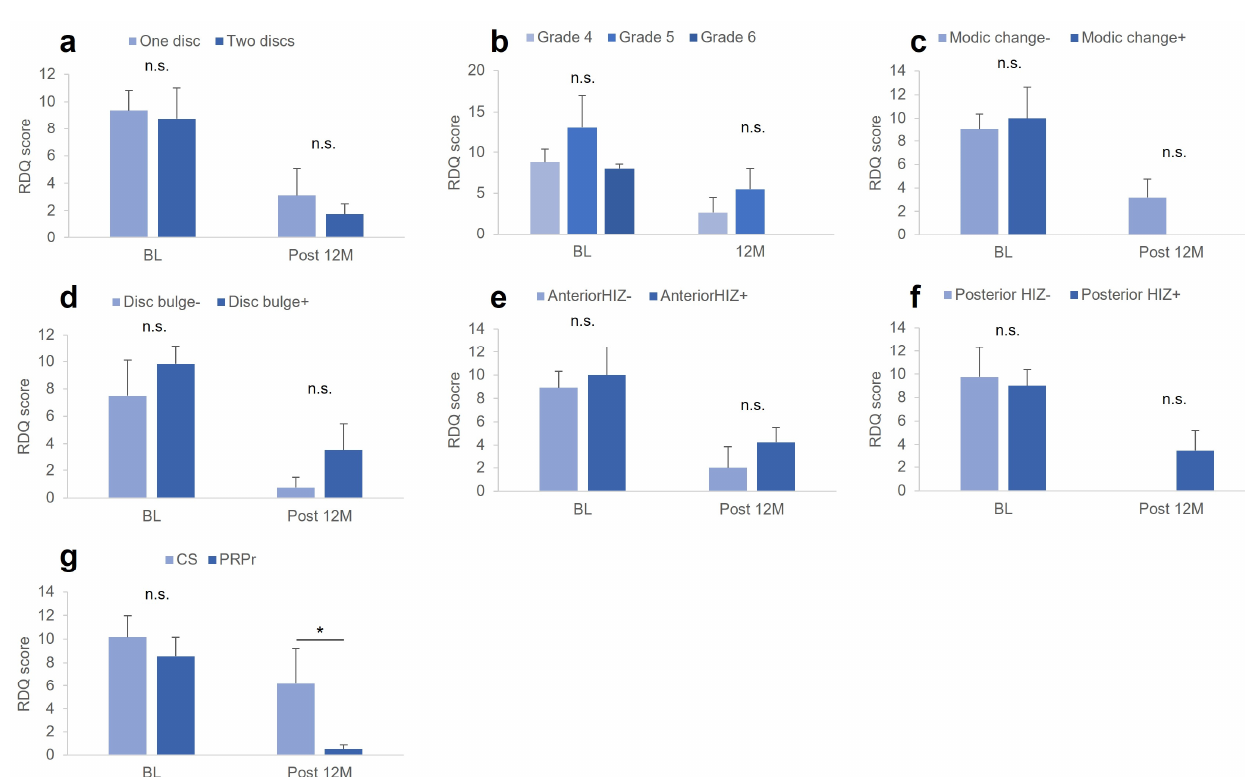
Figure 4. RDQ at baseline and Post 12 M. RDQ scores at baseline and Post 12 M among the groups classified by image characteristics of the targeted discs, including ( a ) number of targeted discs, ( b ) modified Pfirrmann grading, ( c ) Modic changes, ( d ) disc bulge, ( e ) anterior HIZ, ( f ) posterior HIZs, and ( g ) treatment group. CS, corticosteroid; RDQ, Roland–Morris Disability Questionnaire; PRPr, platelet-rich plasma releasate; HIZ, high-intensity zone. * p < 0.05 between the groups. There were no significant differences in the change in RDQ scores among the groups classified according to the baseline characteristics of the targeted discs (Table 4). The